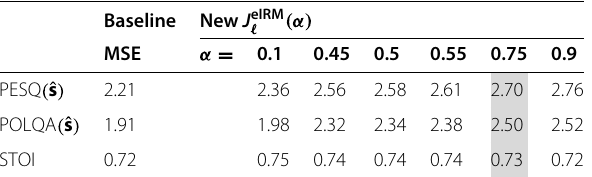
Table 4 Optimization of hyperparameter for the baseline eIRM MSE (3) on 12 . 5 % of the validation set . The selected setting is gray-shaded